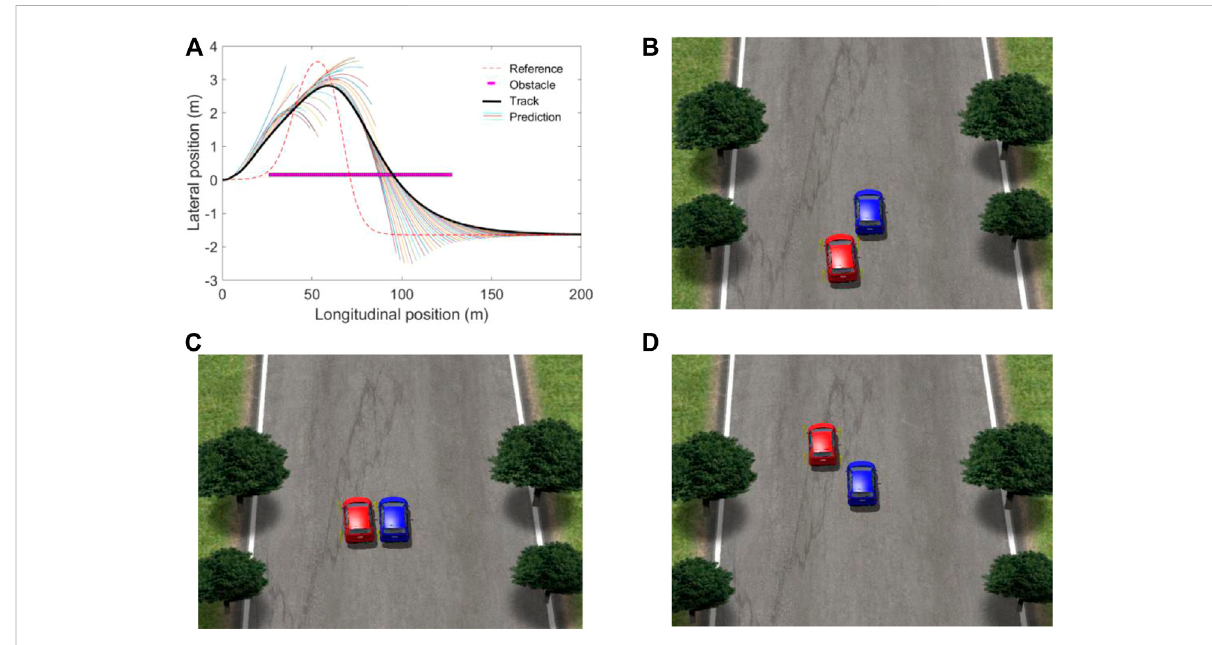
FIGURE 9 Obstacle avoidance trajectory and obstacle avoidance model at 82 km/h. (A) obstacle avoidance trajectory; (B) model before obstacle avoidance; (C) model during obstacle avoidance; (D) model after obstacle